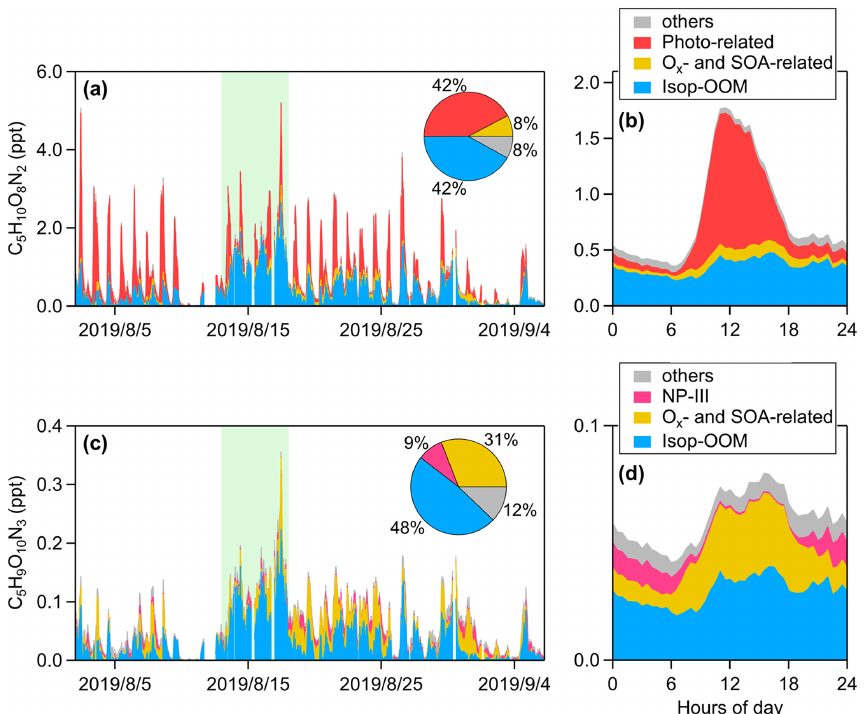
Figure 8. Stacked (a) time series and (b) mean diurnal pattern of isoprene dihydroxyl dinitrate (C 5 H 10 O 8 N 2 ). Stacked (c) time series and (d) mean diurnal pattern of isoprene hydroxyl trinitrate (C 5 H 9 O 10 N 3 ). The contribution ratios of each PMF factor to these two compounds are reported in the respective pie charts. The light-green-shaded area represents a typical episode influenced by transported continental air masses (13 to 17 August